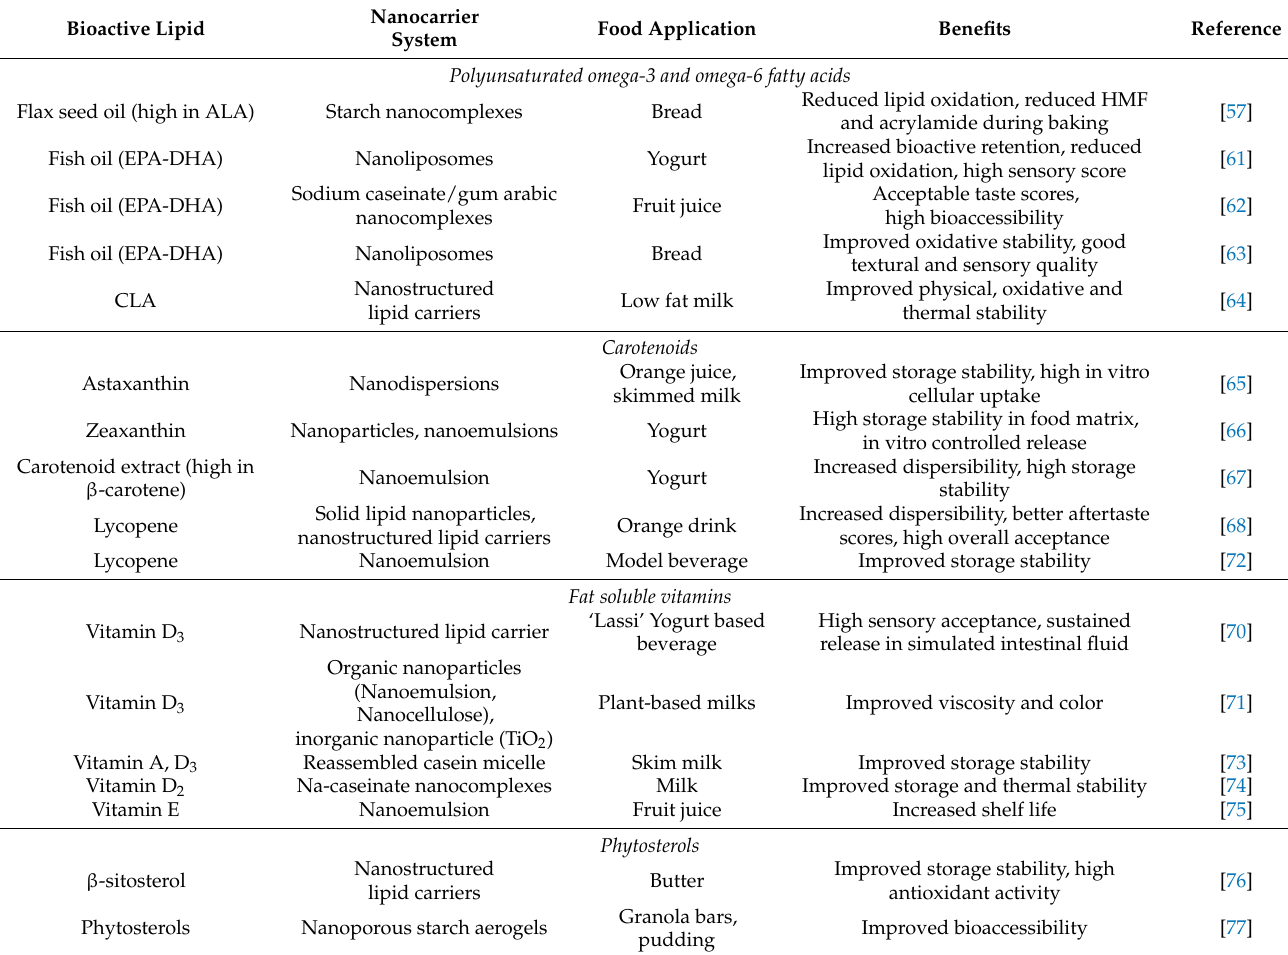
Table 1. Effect of nanoencapsulation on applications of bioactive lipids in foods and